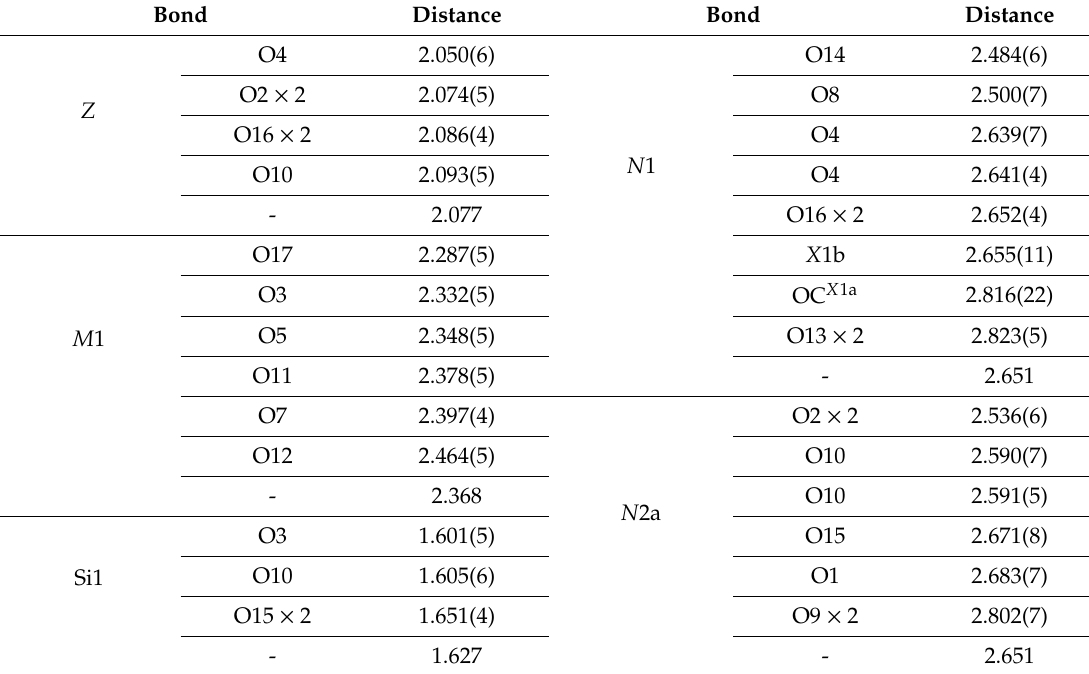
Table 5. Selected interatomic distances (Å) in the structure of